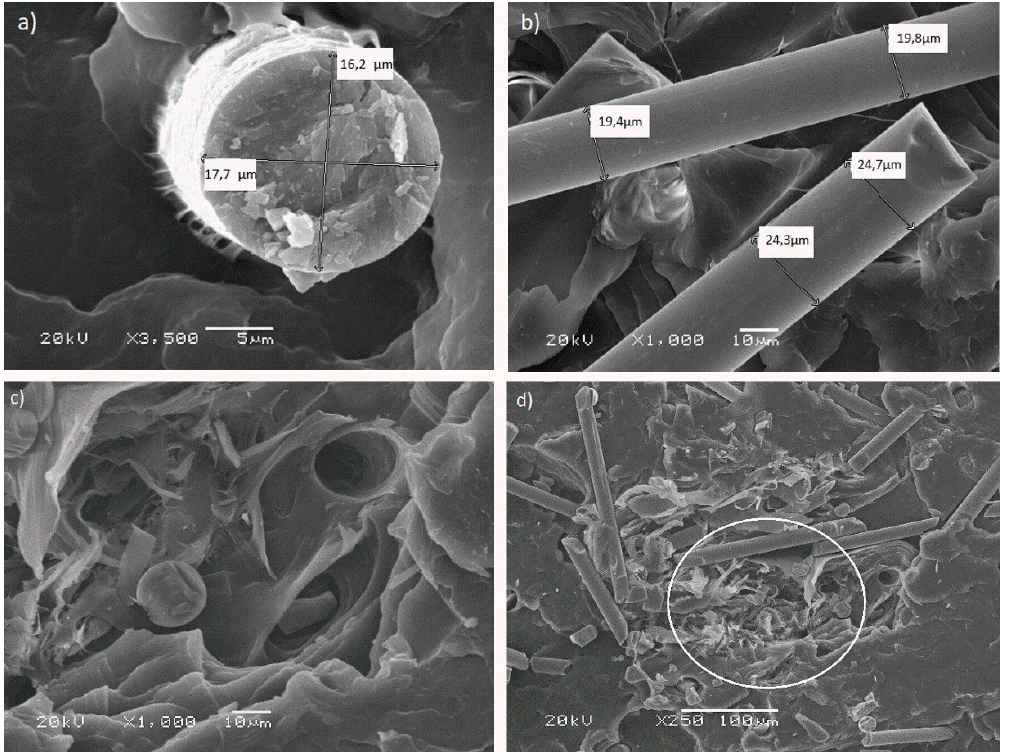
Figure 10. SEM images of the polypropylene (PP) composites with basalt and wood fibers (the fracture after the elongation test): ( a ) PP5B5W at 3500 × magnification—a single basalt fiber in the PP matrix, ( b ) PP10B10W at 1000 × magnification—a group of parallel basalt fibers, ( c ) PP5B5W at 1000 × magnification—a broken basalt fiber and a “whole” fiber after pulling out one of them on the ductile fracture of PP, ( d ) PP5B5W at 250 × magnification—area of entanglement of basalt and wood fibers.